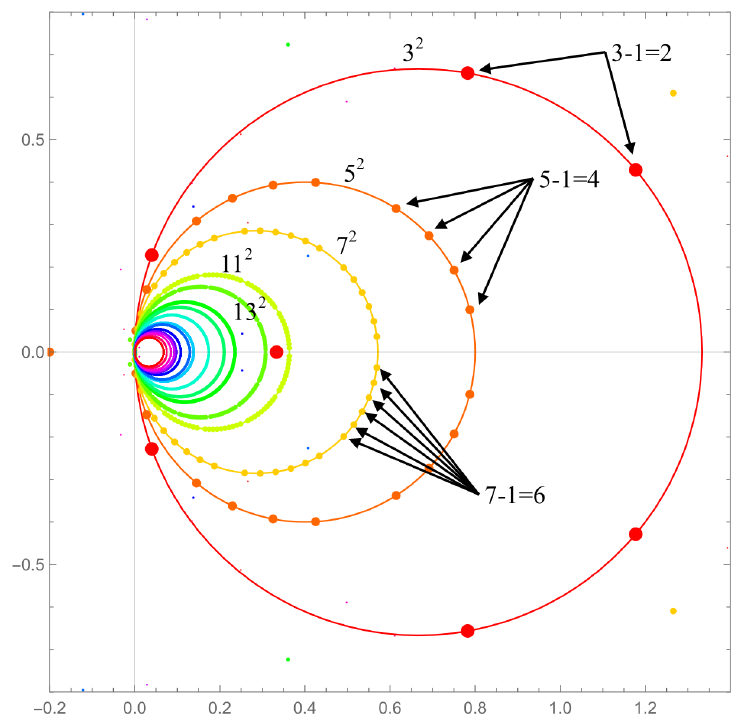
Figure 9. Further investigation of the structure of the discrete Fourier transform for the cases of m as primes squared for the primes from 3 to 31. The circles of radius 2 notes that p sets of p − 1 points are symmetrically arranged around the